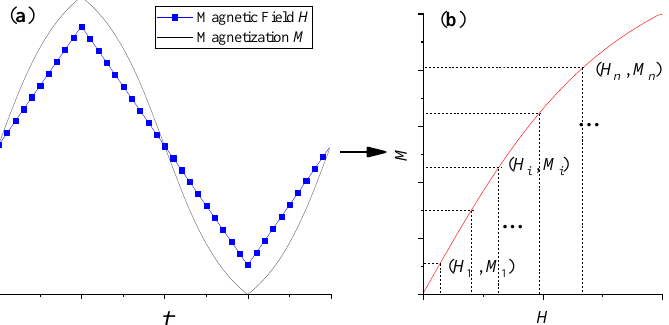
Figure 1. Acquisition, symmetry and discretization of M–H magnetization curve of Magnetic nanoparticles (MNPs) in a low-frequency triangular wave excitation magnetic field. ( a ) The low-frequency triangular wave magnetic field (H ) and the magnetization ( M ) of MNPs versus time ( t ), respectively. ( b ) The corresponding M-H magnetization curve after quarter period symmetry processing.